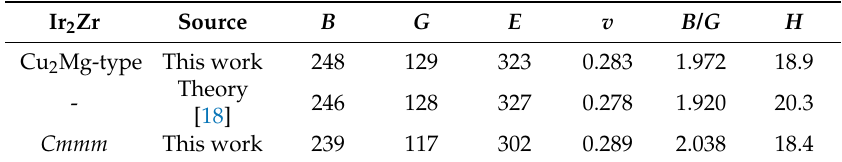
Table 2. Calculated polycrystalline bulk modulus B , shear modulus G , Young’s modulus E , and hardness H (in units of GPa) for Ir 2 Zr. Also shown are Poisson’s ratio v and B/G